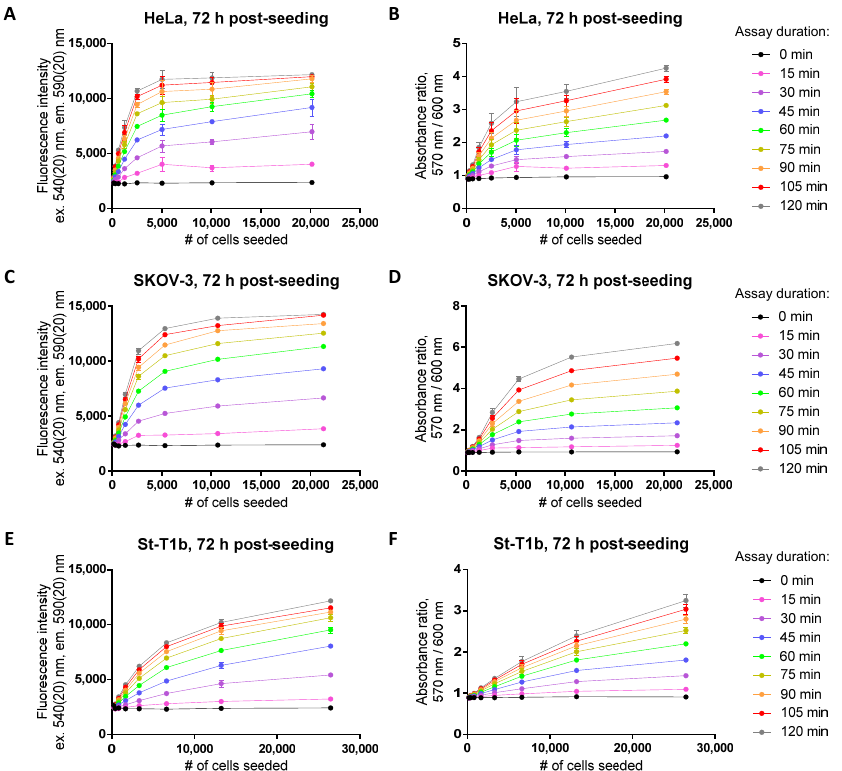
Figure 3. Establishment of the dynamic range in the resazurin assay for cervical cancer (HeLa; A , B ), ovarian cancer (SKOV-3; C , D ), or healthy immortalized endometrial stroma ( E , F ) cell lines at 72 h post-seeding. Detected optical characteristic: fluorescence intensity (excitation at 540 nm) in ( A , C , E ); absorbance ratio (570 nm/600 nm) in ( B , D , F ). Measurements were carried out at 50 μ M resazurin (incubation times with resazurin indicated in the legend on the right). In each graph, the average of duplicates or triplicates ± SEM from a single representative experiment is shown.